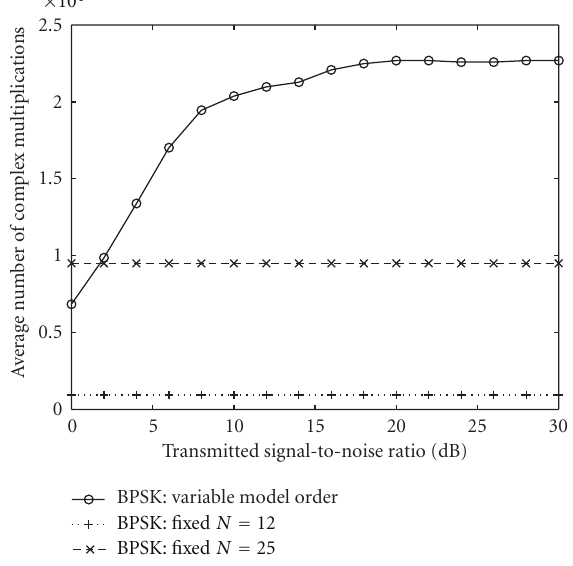
Figure 3: Computational complexity margin ratio versus model order N (fixed model order: ( C (cid:2) R − 1 variable model order: ( C (cid:2) R − 1 equality line is for the margin ratio = 0%; N is the fixed or the terminal model order therein).